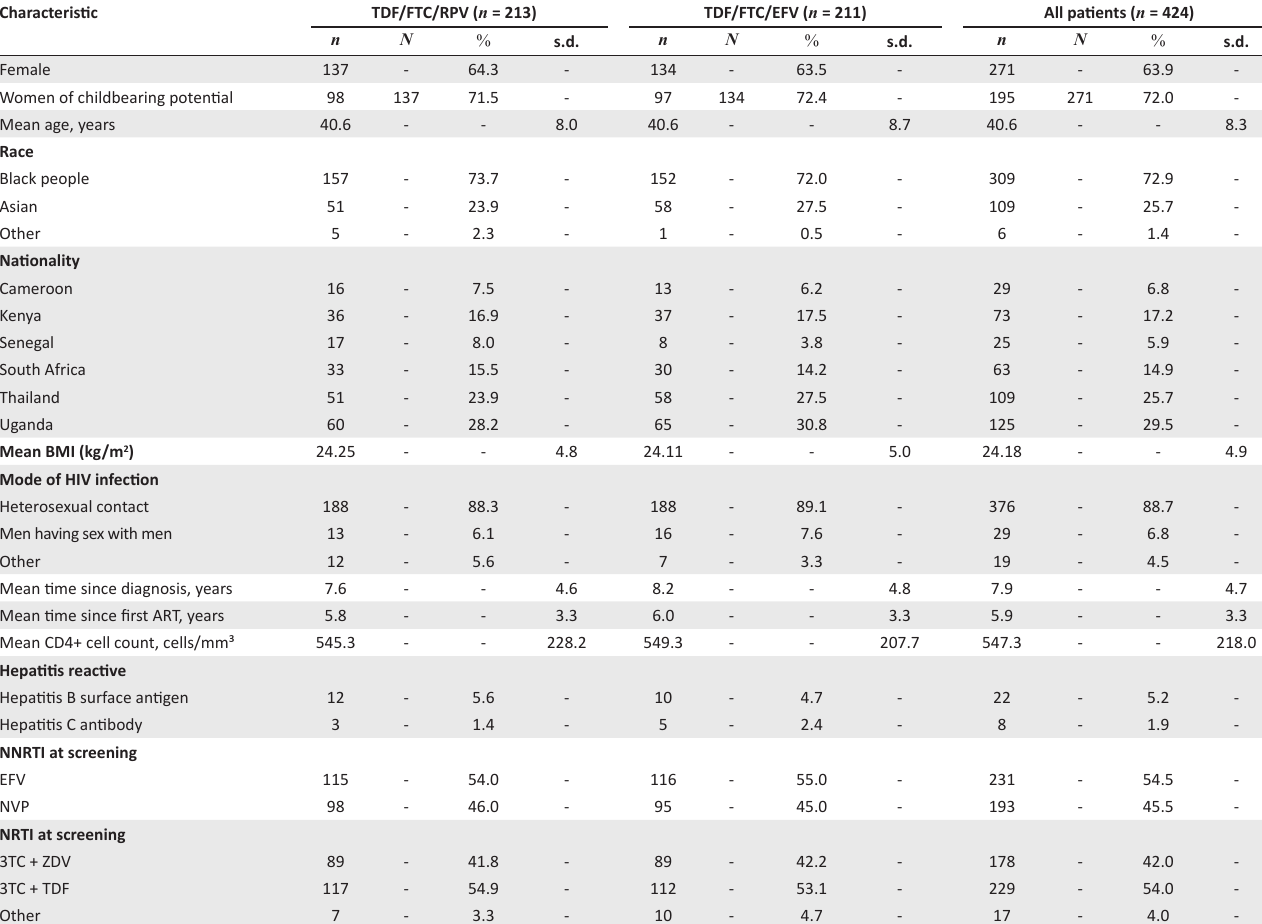
TABLE 1: Baseline and disease characteristics . Characteristic